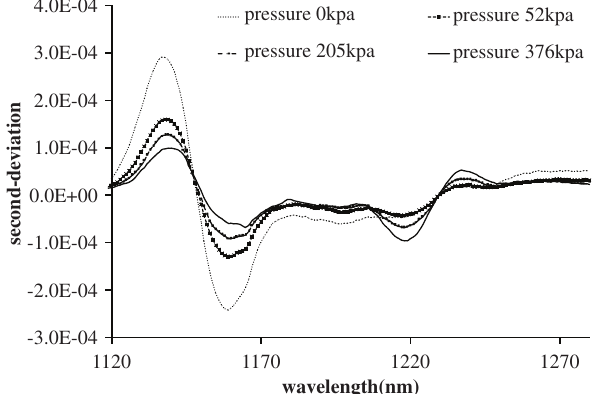
Fig. 5. Variation of second-derivation with probe pressure increased.